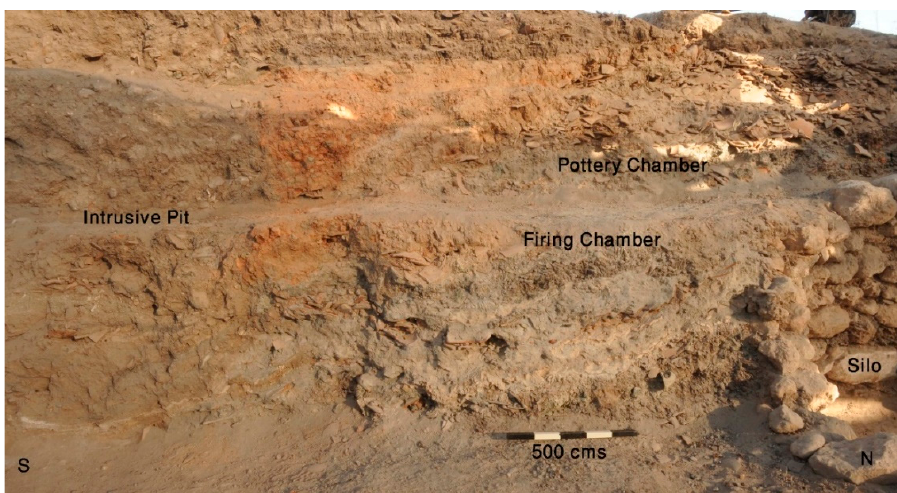
Figure 1. Photograph of the section through the kiln, with the pottery chamber located above the firing chamber. The pit and the silos are intrusive features The pit has been dated to the Mamluk period some 600 years after the kiln was in operation in the 7th Century CE [15].